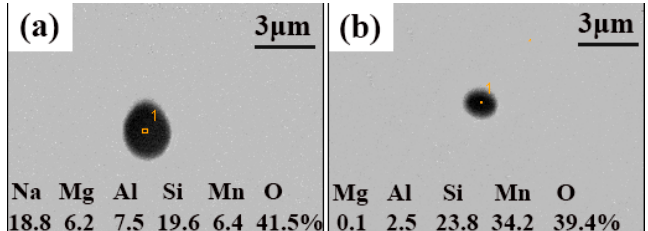
Figure 11. Typical morphologies and composition (wt%) of inclusions in Heat D.